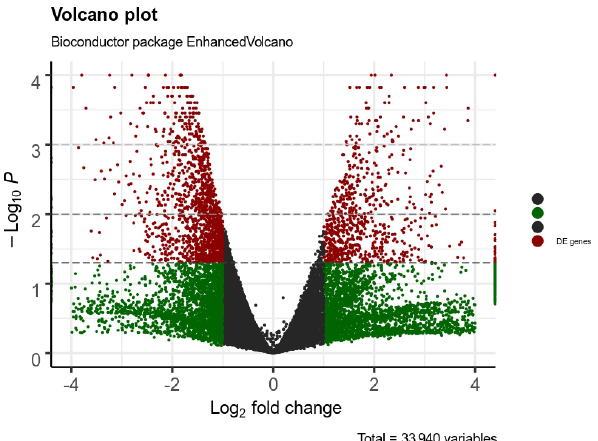
Figure 3. Volcano plot of expressed genes of adipose tissue of Zel (thin-tailed) compared to Ghezel (fat-tailed) sheep breeds. The y axis illustrates − log 10 p values, and the x axis corresponds to a log 2 -fold change of gene expression between Zel and Ghezel sheep breeds. The red points represent significant genes ( p value <